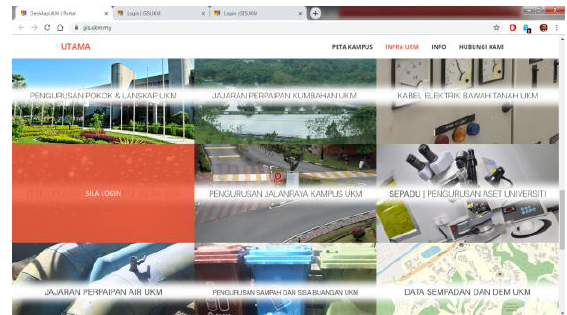
Figure 9 . Current available modules on UKM GIS online portal.